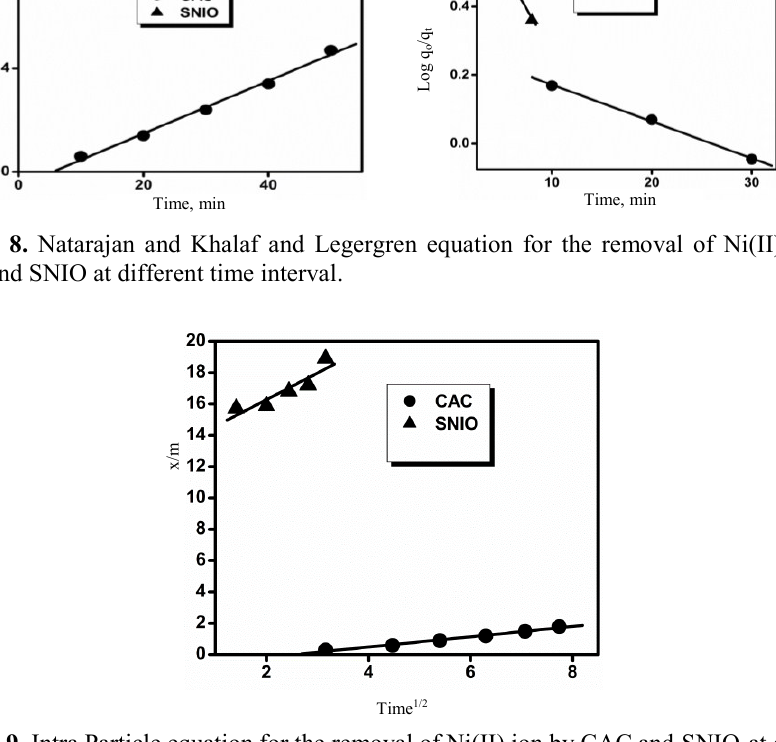
Figure 9. Intra Particle equation for the removal of Ni(II) ion by CAC and SNIO at different time